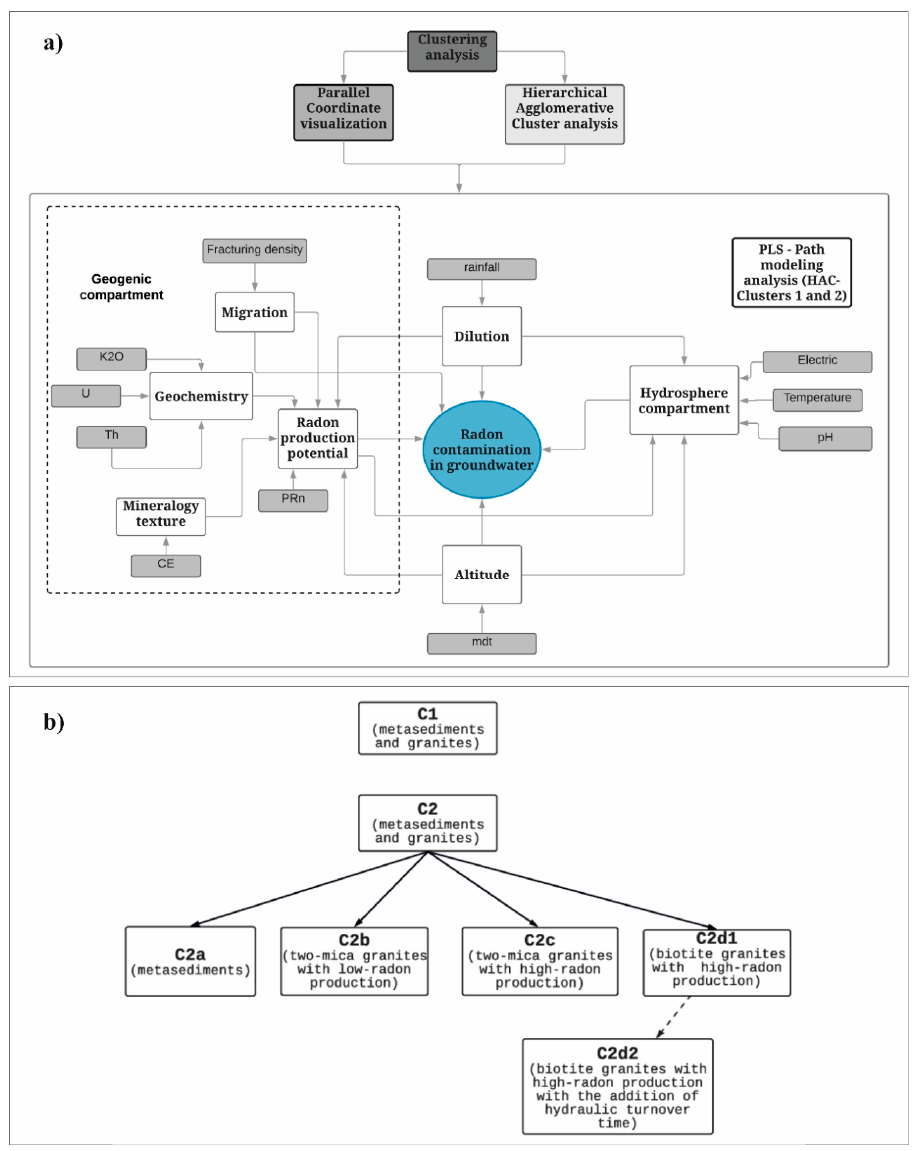
Figure 3. Risk of radon contamination in groundwater, comprising the planning workflows: ( a ) clustering analyses with hierarchical agglomerative cluster (HAC) analysis projected in a parallel coordinate plot (PCV), and the partial least squares-path modeling (PLS-PM) of clusters obtained by the previous method; ( b ) technical workflow of the data used for PLS-PM modeling, adding the division of cluster 2 from a geological perspective. The details of this technical workflow are provided in Section 3.3.